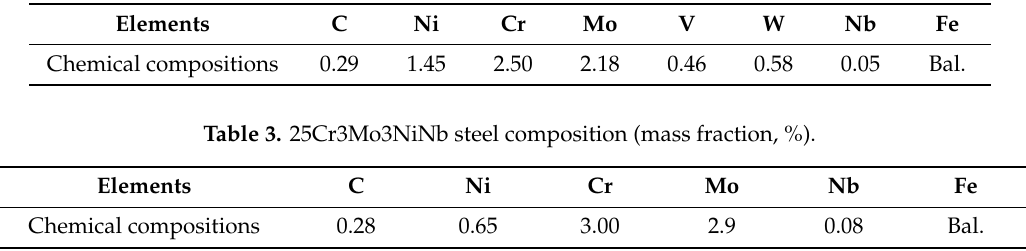
Table 2. 25Cr3Mo2NiWVNb steel composition (mass fraction, %).